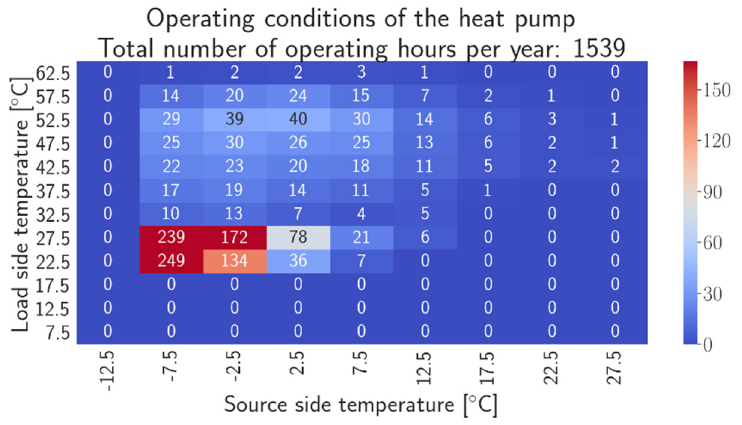
Figure 15. Heat map of the operating temperature at which the heat pump is operated throughout the year.